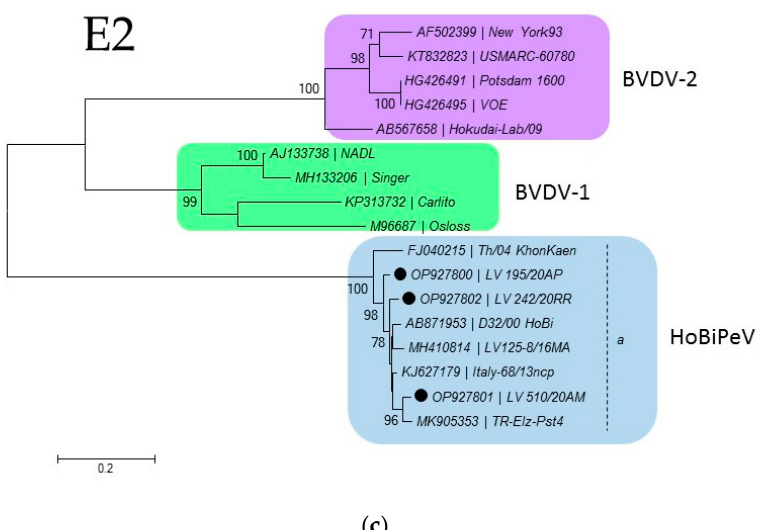
Figure 2. Molecular phylogenetic analysis by the maximum likelihood method. Phylogenetic tree based on the nucleotide sequence: ( a ) 5 (cid:48) UTR, ( b ) N pro , and ( c ) E2. Phylogenetic analysis for subgenotype classification was performed using the BVDV sequences obtained from